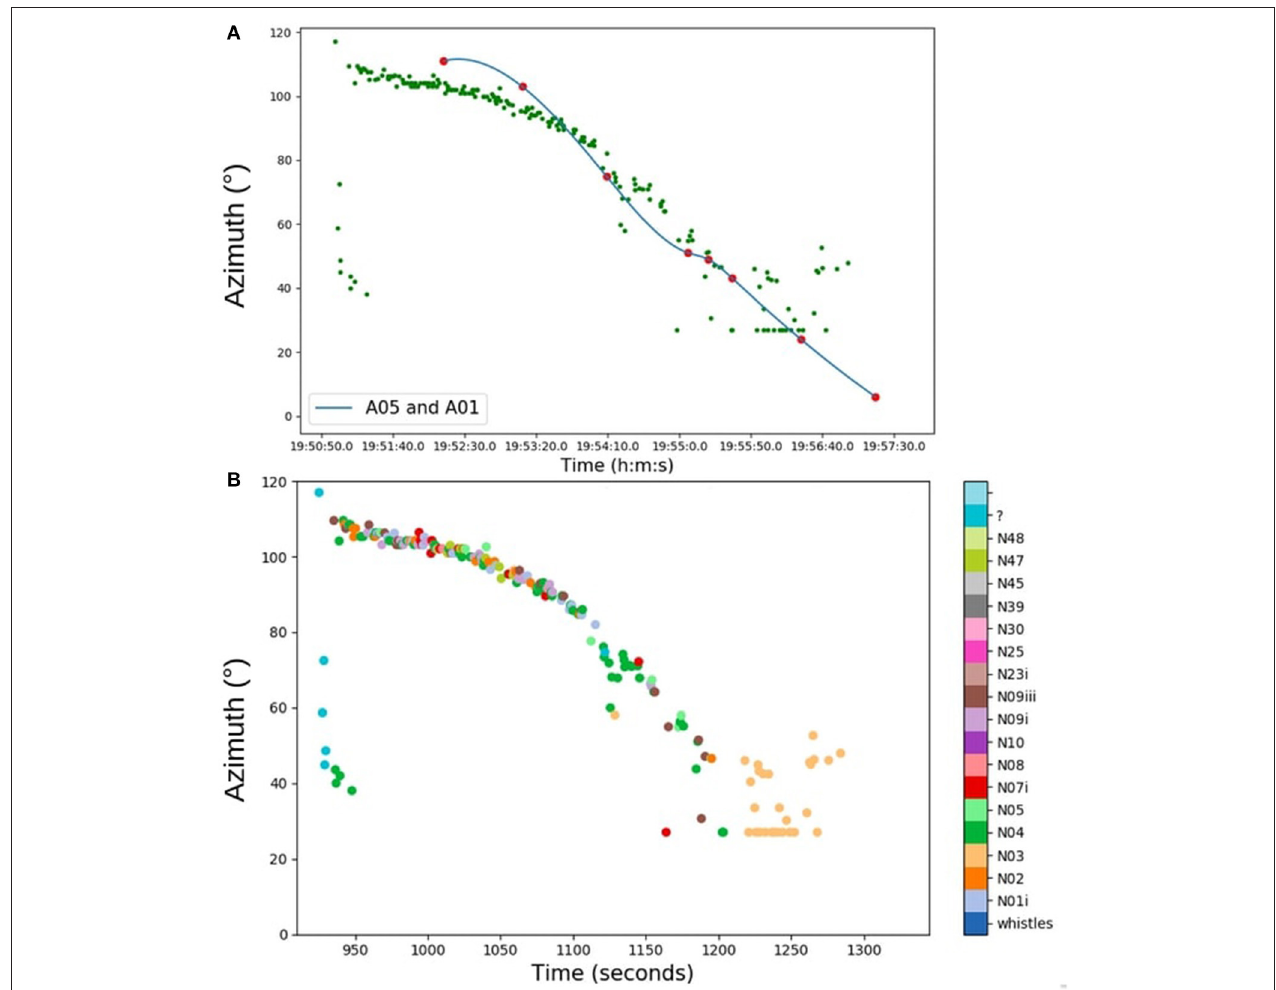
FIGURE 8 | (A) Graph of the passage of the 30 th of August. Each green point represents a vocalization placed in azimuth. The blue curve is the interpolation of the A05 and A01 visual azimuth estimations. (B) Graph of the passage of the 30th of August. Each point represents a vocalization placed in azimuth. Each color represents a type of